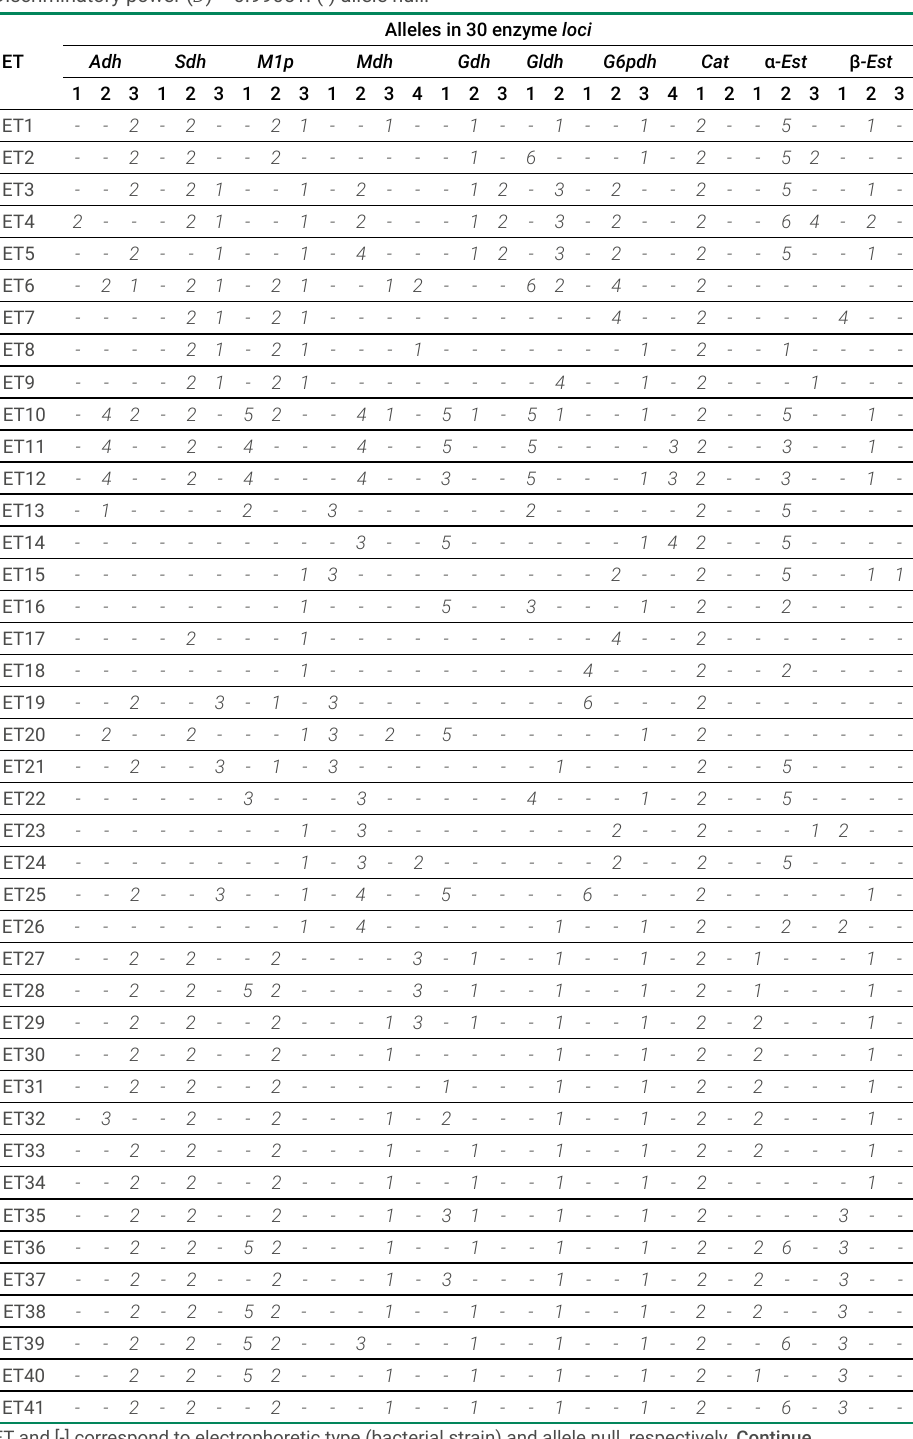
Table 2. Allele profiles of oxacillin-resistant S. aureus isolates (79 strains/ETs), sourced from odontological clinical and environment samples, and obtained for the genetic interpretation of MLEE patterns. Discriminatory power ( D ) = 0.99051. (-) allele null.